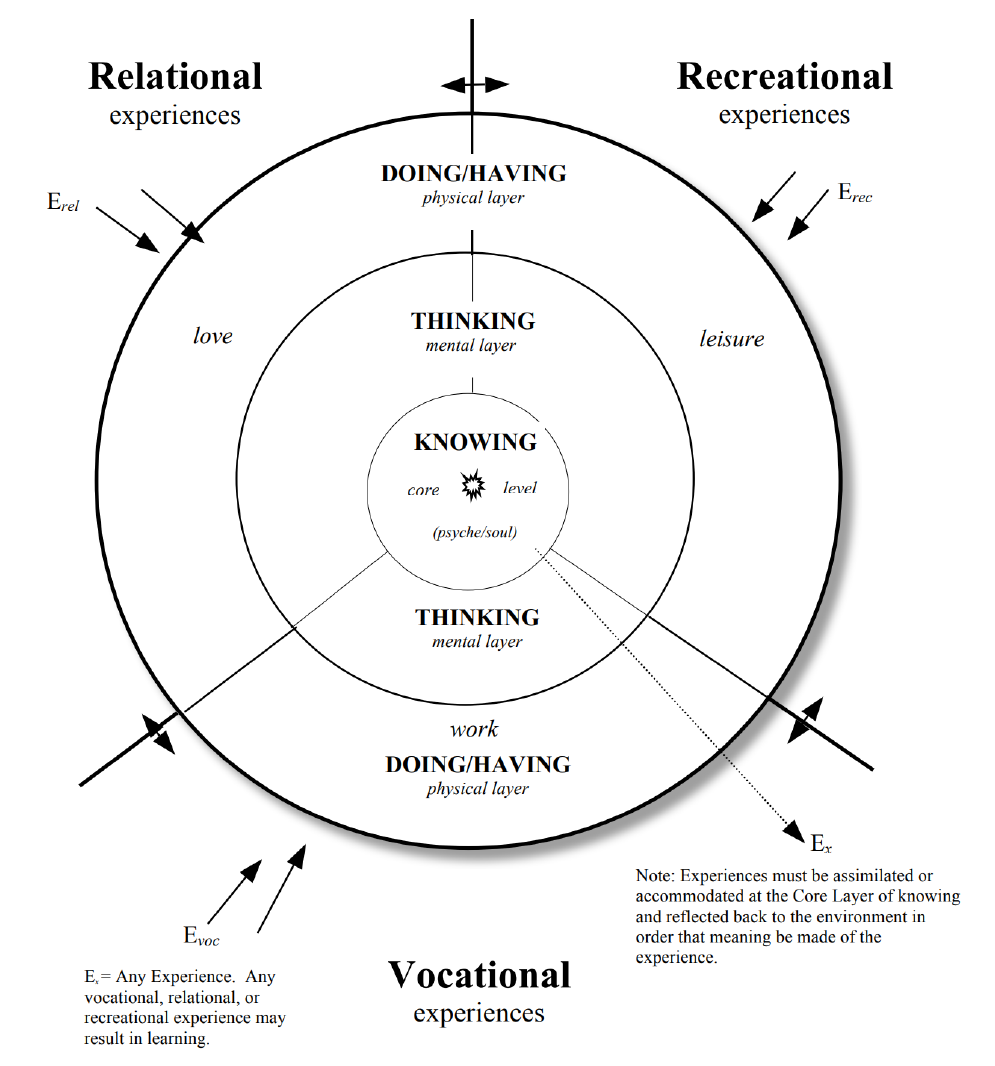
Figure 1. Dynamic Integration